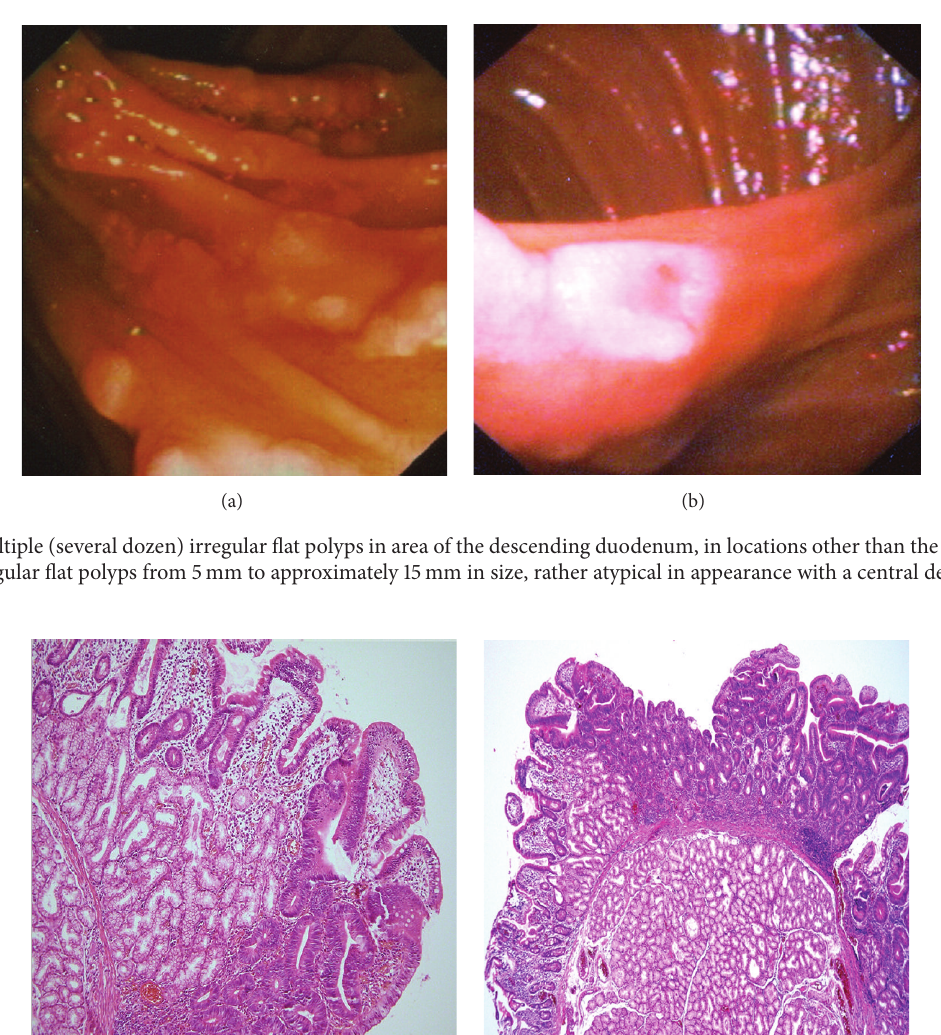
occurred intermittently. Family medical history was